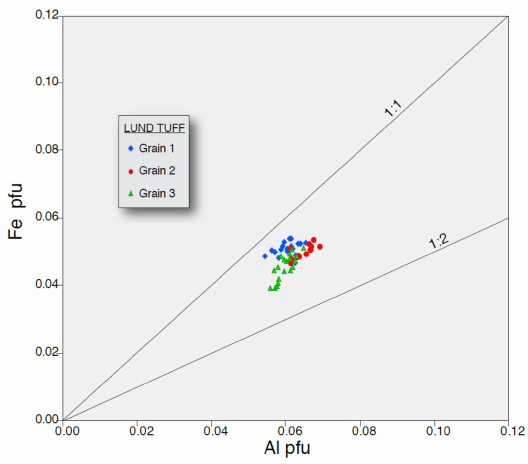
Figure 5. Fe versus Al for three titanite grains from the Cenozoic Lund Tuff of western Utah.